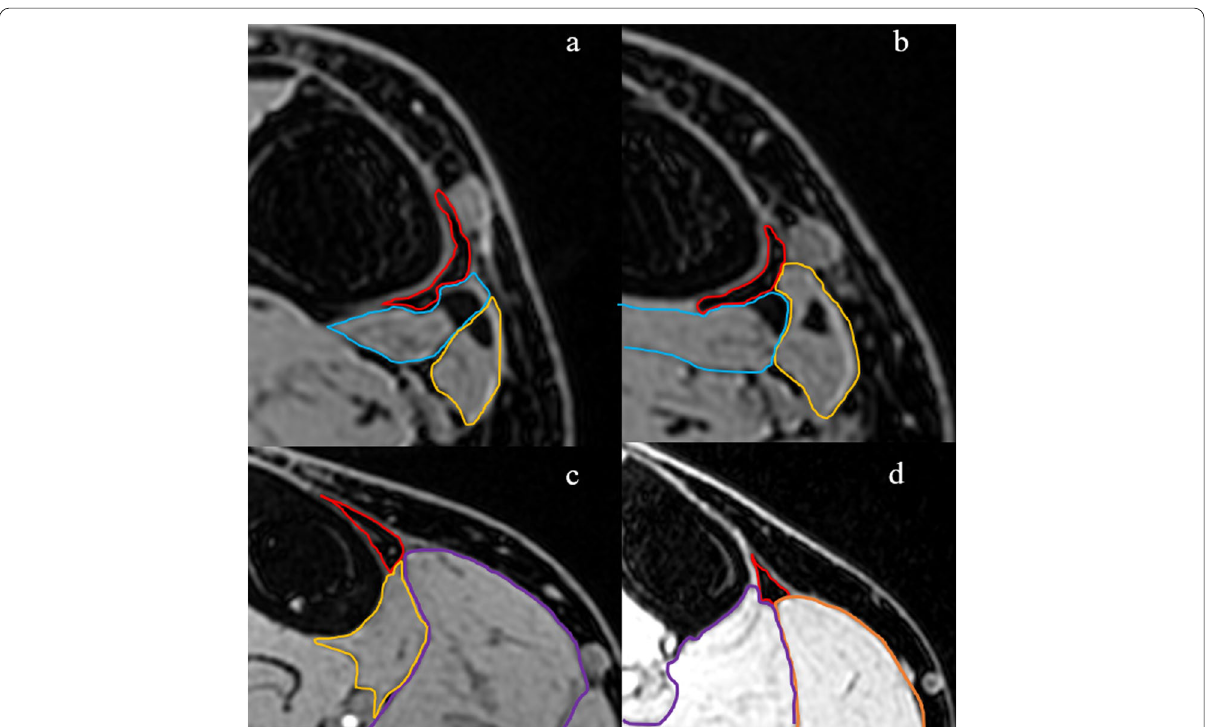
Fig. 4 a, b , and c : A 23-year-old man. d : A 24-year-old man. Water-only transverse plane images obtained using LAVA-Flex show soft tissue enclosing the posterior aspect of the adipose tissue. Images acquired at a : 6 cm; b : 9 cm; c : 21 cm; and d : 27 cm from the distal tip of the medial malleolus. Red line: adipose tissue; blue line: posterior tibialis muscle and tendon; yellow line: flexor digitorum longus muscle and tendon; purple line: soleus muscle; orange line: medial head of the gastrocnemius